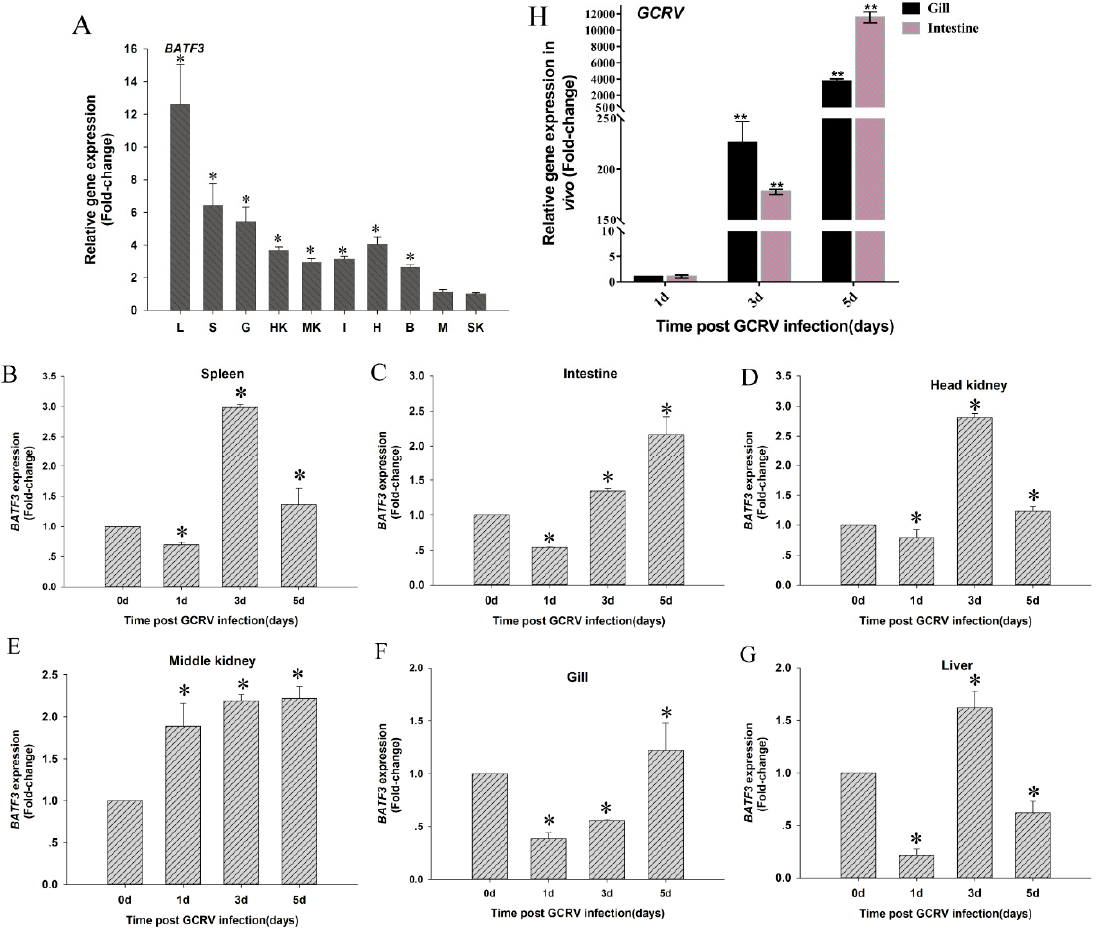
Figure 3. ( A ) Tissue distribution of CiBATF3 ; ( B – G ) the expression patterns of CiBATF3 in immune- related tissues after GCRV challenge; and ( H ) the expression of the S6 gene in gill and intestine. The expression level of the control group was set as the baseline (1.0). The results are presented as the mean ± SD ( n = 5). The abbreviations of 10 examined tissues. L, liver; S, spleen; G, gill; HK,